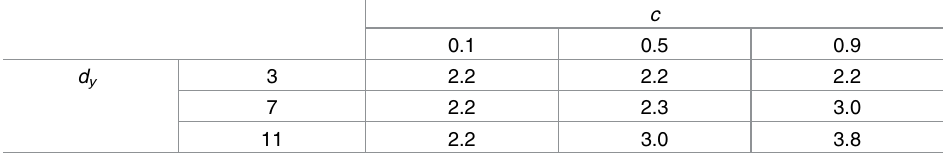
Table 1. Scaling factor k used to generate stable trials given their dimensionality d y and connection density c